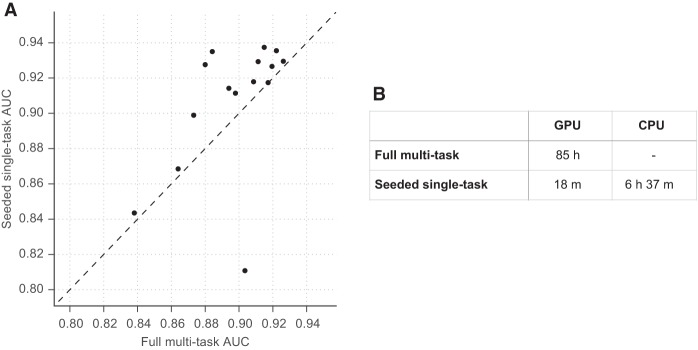
Basset leverages large-scale public data to inform additional data set learning. (A) The scatter plot shows AUC for 15 data sets achieved by the full model trained on all 164 cell types on the x-axis and AUC achieved by a procedure to simulate studying that data set alone on the y-axis. To study the data set alone, we pretrain a model on 149 cells (after removing these 15), seed training of the additional cell with that model's parameters, and perform a single training pass through the new data. This rapid procedure was effective for all but one data set (HRCEpiC, renal cortical epithelial cells), for which multitask training with the many other similar epithelial cells was beneficial. The AUC improvement for many cells suggests that our full model may benefit from increased capacity or decreased regularization. (B) The seeded training procedure is far faster on the GPU and allows for feasible CPU training.